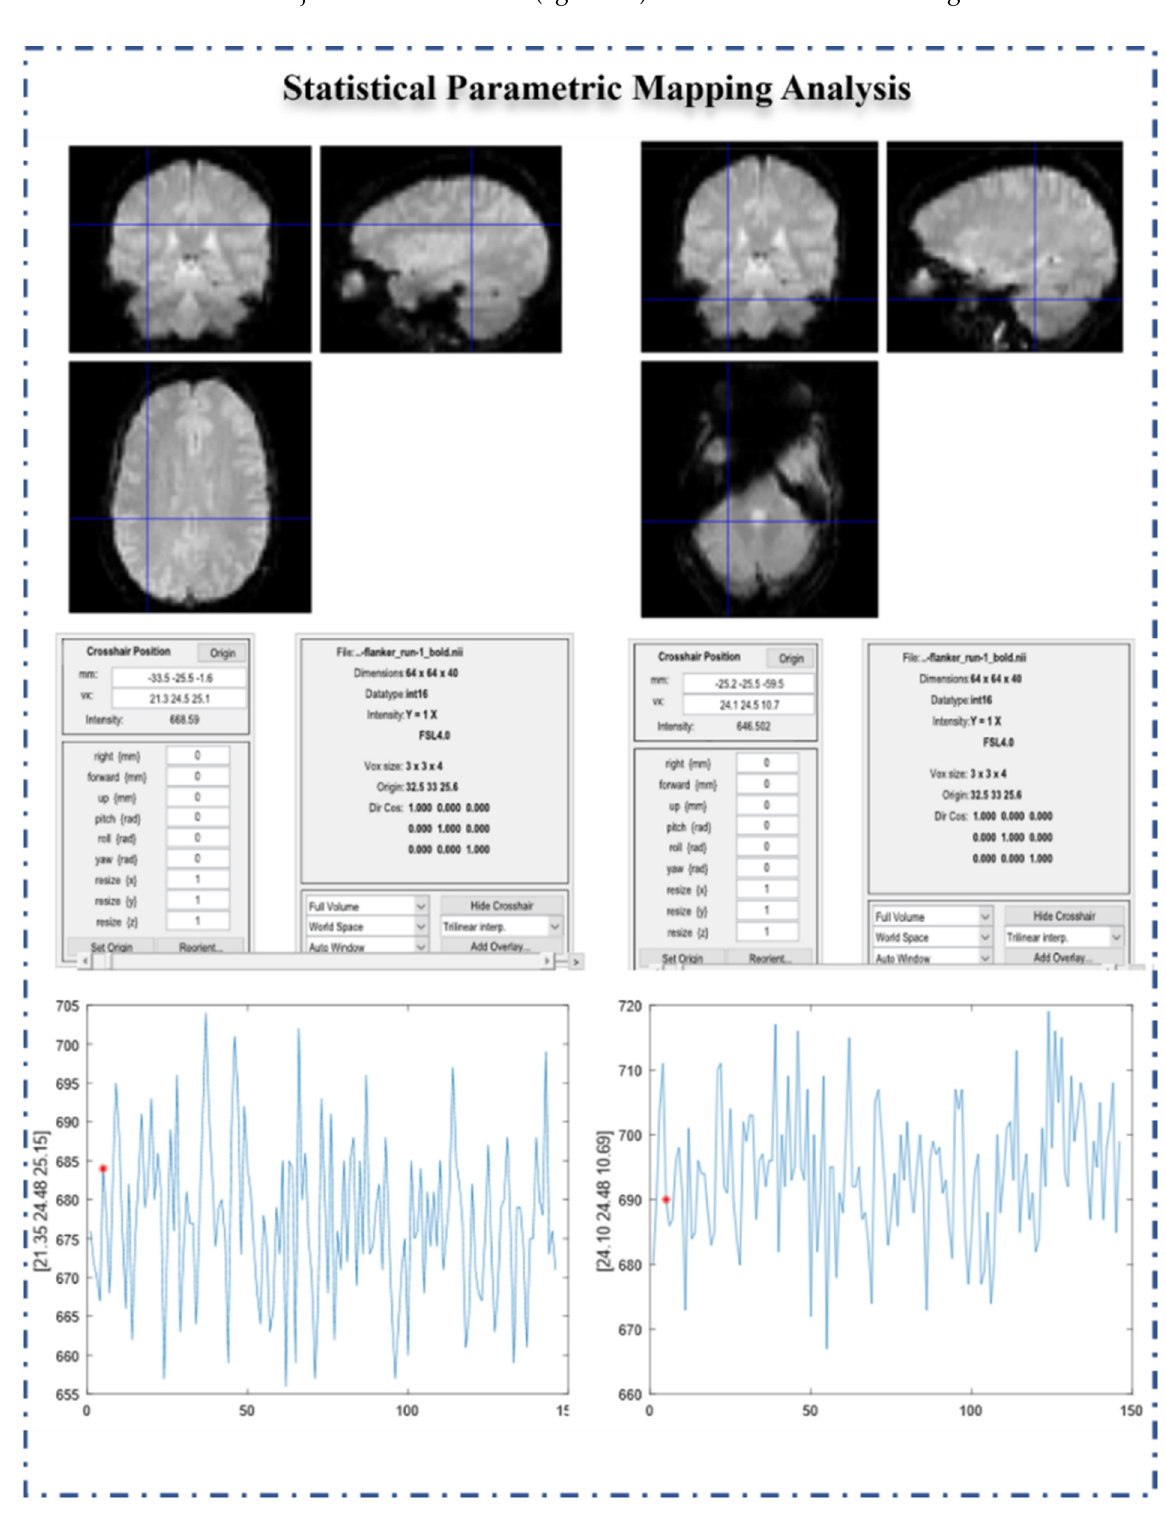
Figure 4. Functional images generated from SPM viewer for both NC ( left ) and AD patients( right ). The interpretation of generated images requires extensive knowledge of fMRI and neurological disorders. Voxel time series for both subjects are displayed using signal graphs ( down ).